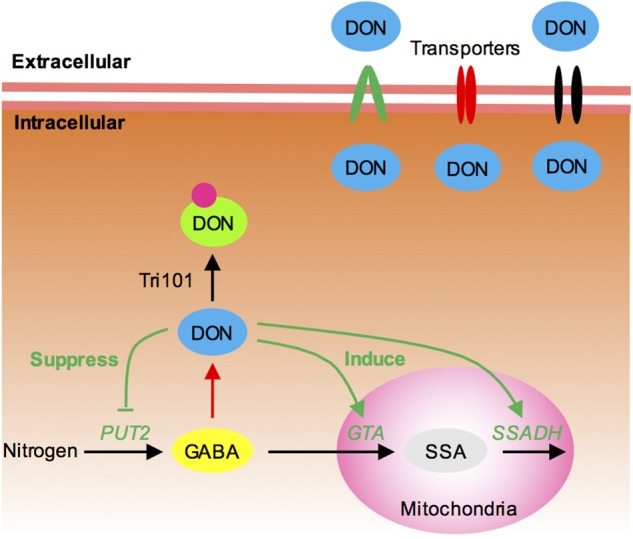
Proposed model for the self-defense mechanism in F. graminearum. (1) Tri101, which acetylates DON into a hypotoxic form, is shown to contribute to self-defense. (2) Many MFS transporters, including Tri12, are likely to export intracellular DON. (3) GABA mediates DON production and self-defense in F. graminearum. In most cases, increasing GABA accumulation will result in increasing DON production (red line). However, higher concentrations of intracellular DON may feedback inhibit DON production by reducing GABA accumulation (green line). It suppresses the expression of GABA biosynthesis gene PUT2-2 and induces the expression of GABA degradation genes GTA and SSADH, preventing further DON accumulation.